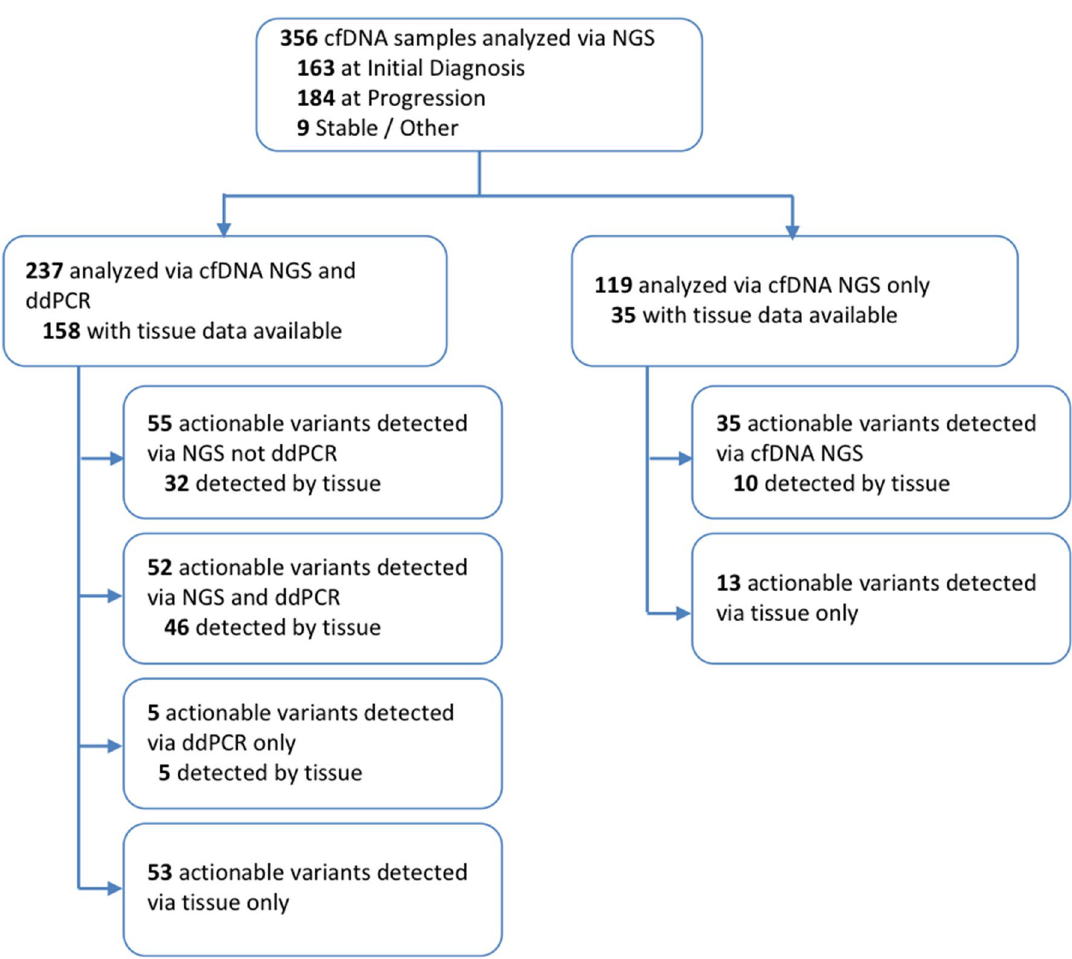
Figure 1. Flow chart summarizing types of tests conducted as part of our study, and numbers of actionable variants detected in each sub-group. 237 patients were analyzed by both cfDNA NGS and ddPCR, and of these tissue NGS data was available for 158 patients. 119 patients were analyzed by cfDNA NGS but not ddPCR; of these, 35 had tissue NGS data mutation rates remained high at both timepoints. The overall prevalence of mutations by type is summarized in Fig. 4. The number of unique mutations per gene observed in our 356-sample set is compared to similar measures for lung (Fig. 5) and other cancer tissues (Supplementary Fig. S2) across the same 56-gene pan-cancer targeted regions. The somatic molecular signature of solid tumors in tissue as captured by The Cancer Genome Atlas (TCGA), containing full exon tissue sequencing data from over 300 cancer patients from a number of different indications 15,16 and crossed with our panel coverage. Agreement with the lung adenocarcinoma data set (R 2 = 0.91, Fig. 5) is significantly better with respect to unique mutation counts per gene than for melanoma, colon and bladder cancers, demonstrating that the cfDNA assay is accurately capturing lung cancer variant signatures (Supplementary Fig. S2. C, D, E; R 2 = 0.51, 0.54, 0.86, respectively).